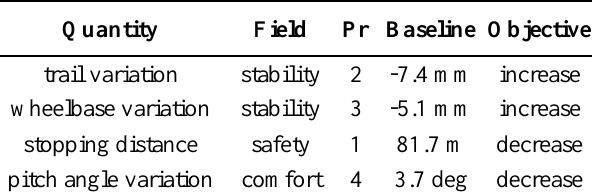
Table 1. Objectives and their priority